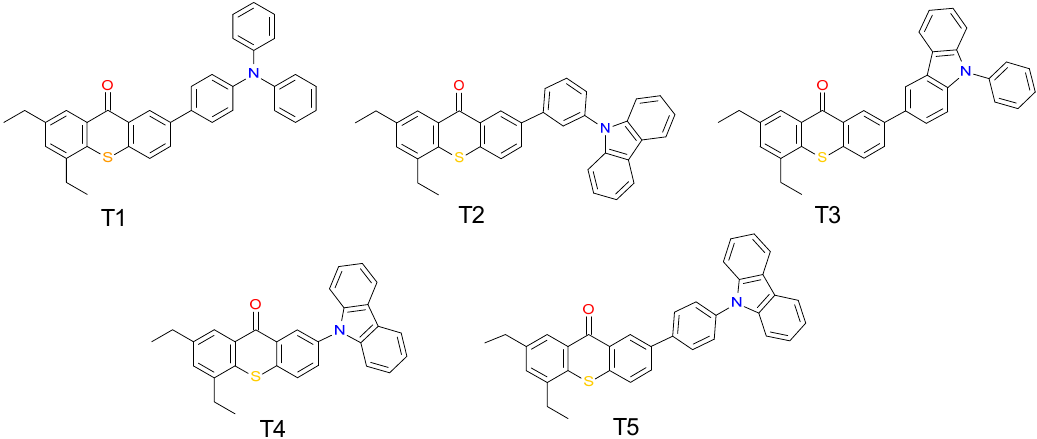
Table 1. Light absorption data of 2,4-diethyl-thioxanthen-9-one derivatives in acetonitrile: maximum absorption wavelengths ( λ max-abs), molar extinction coefficients ( ε ) at λ max and at the maximum of the emission wavelengths of the LEDs 405 nm and 420